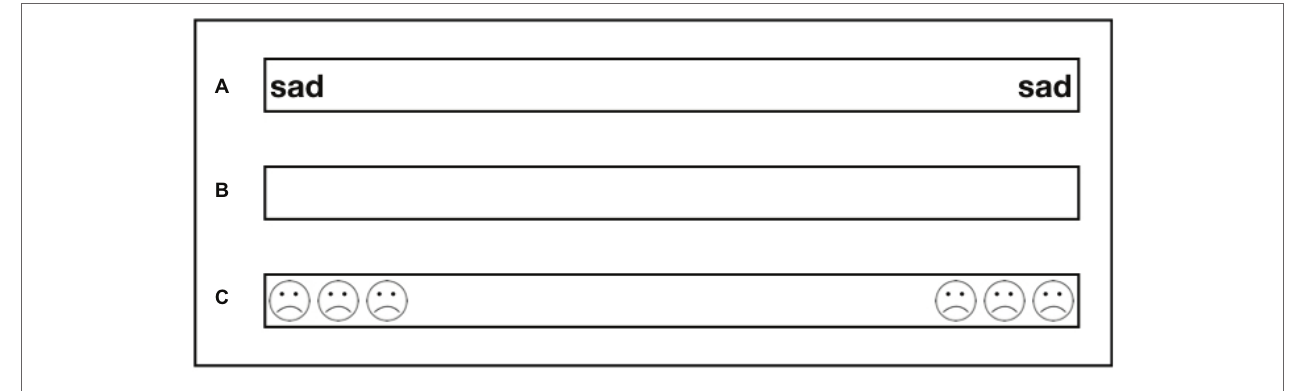
FIGURE 2 | Illustration of the various line types. (A) Horizontal negative word line; (B) Horizontal blank line; (C) Horizontal negative smiley